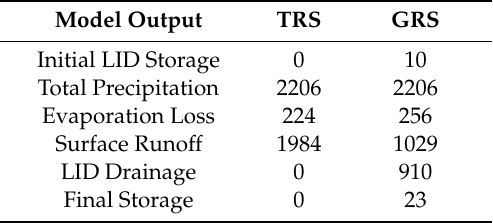
Figure 9. Daily mean GRS ET over 31 years (from 1985–2015). Table 7. Comparison between the TRS and GRS in continuous simulation in 2015 (Unit: